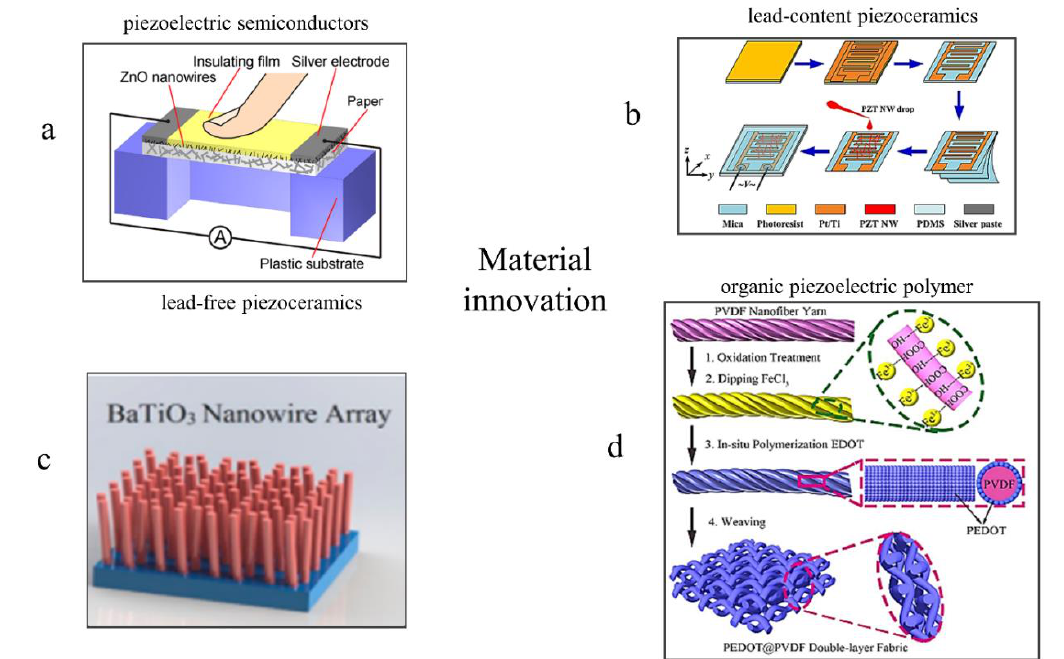
Figure 3. Material innovation: piezoelectric semiconductors, inorganic piezoceramics and organic piezoelectric polymer. ( a ) structure of a sensor based on ZnO. Copyright from ACS. ( b ) structure of a sensor based on Pb x Zr 1 − x TiO 3 (PZT). Copyright from ACS. ( c ) structure of a sensor based on BaTiO 3 . Copyright from ACS. ( d ) structure of a sensor based on PVDF. Copyright from Springer Nature.